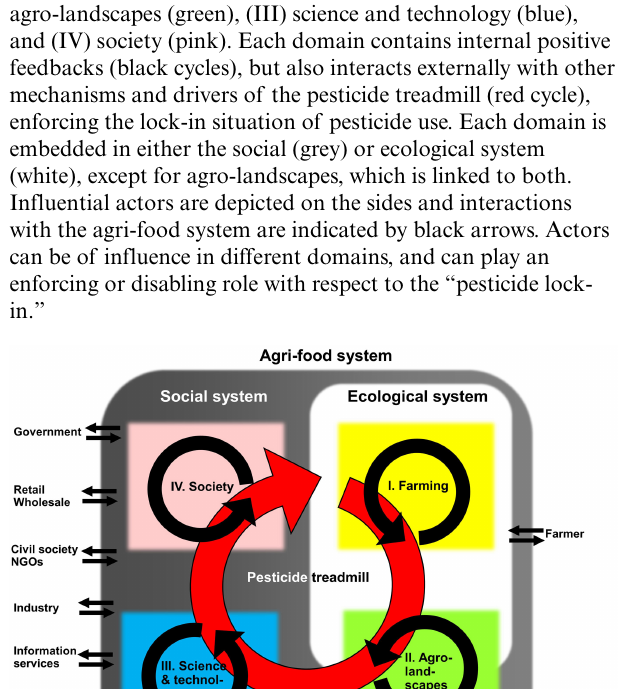
Fig. 1 . A conceptual framework of the “pesticide treadmill.”